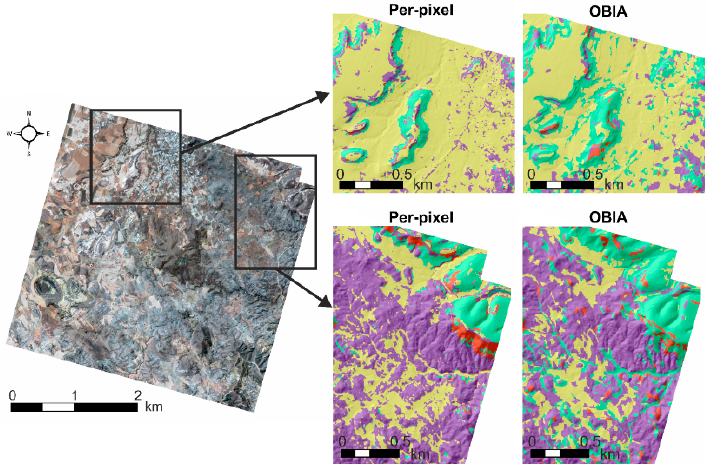
Figure 9. Comparison of the mapping results generated using the best OBIA (ATM-Li) and per-pixel (ATM-Li MNF) approaches.